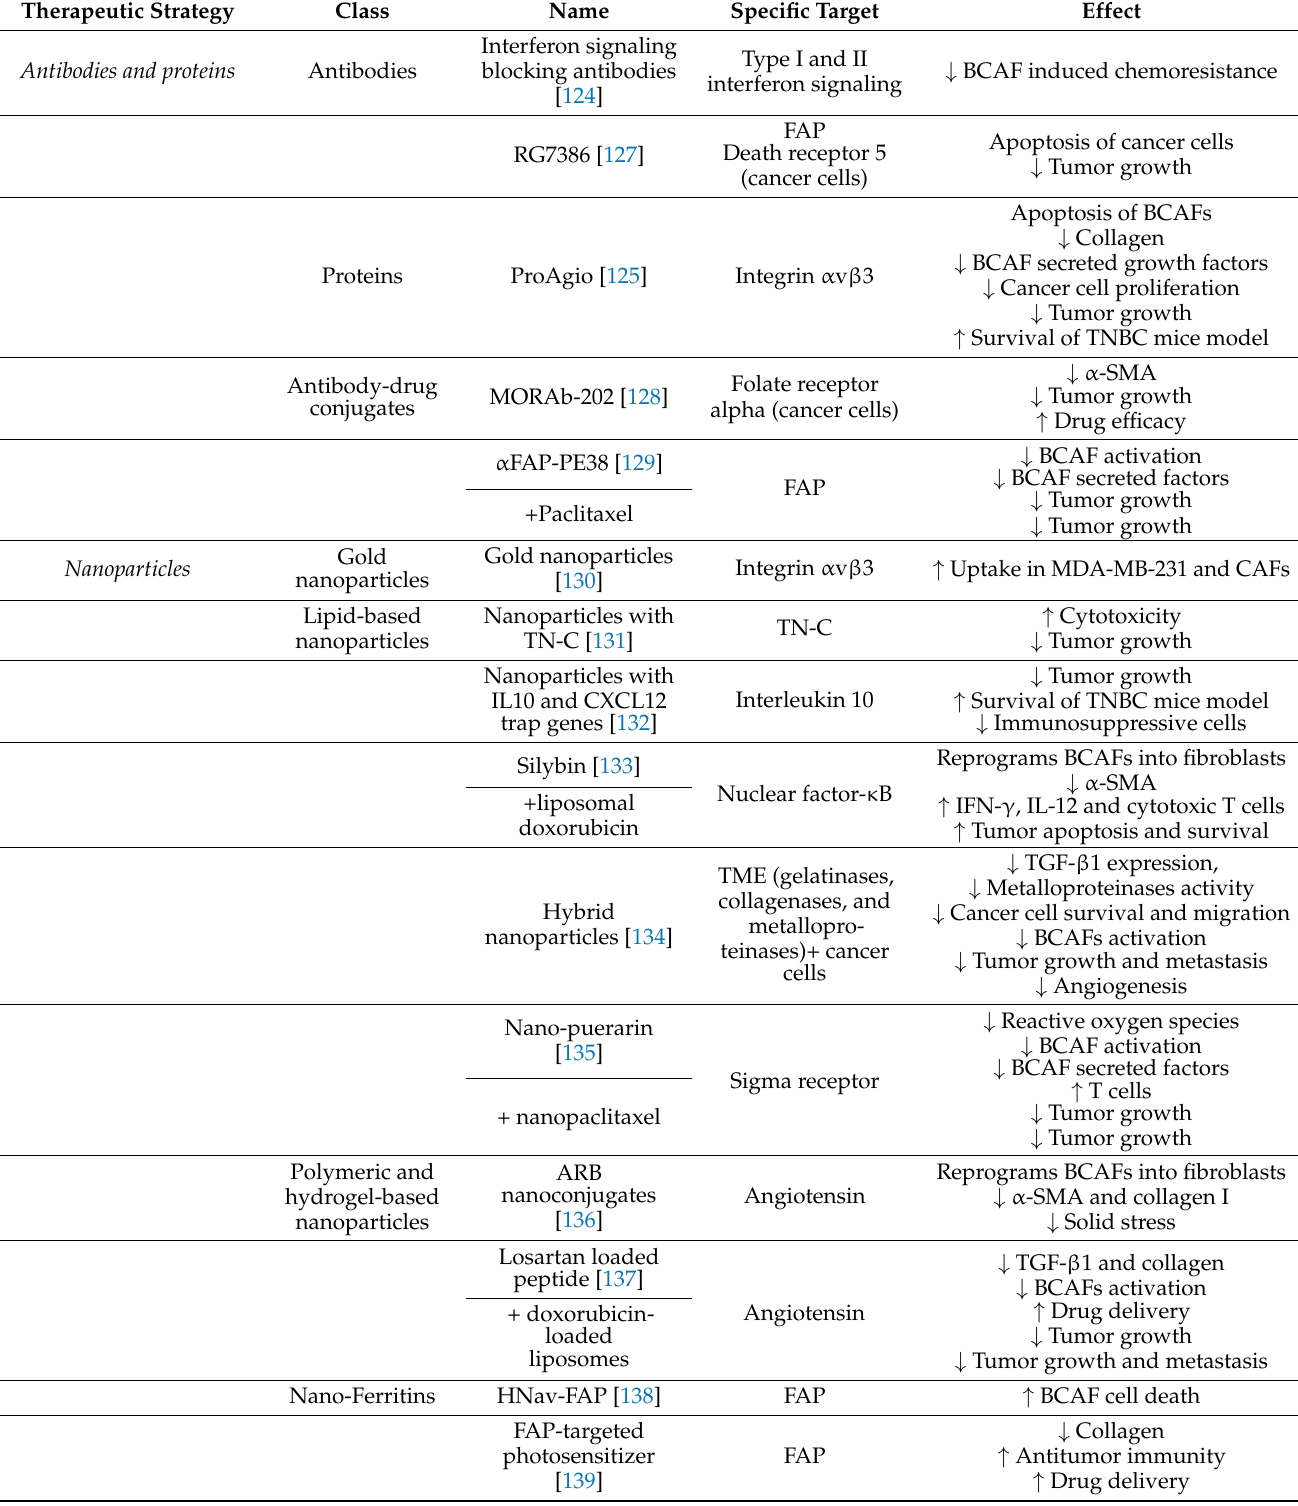
Table 2. BCAF targeting therapeutic candidates (Antibodies, proteins, and nanoparticles) in